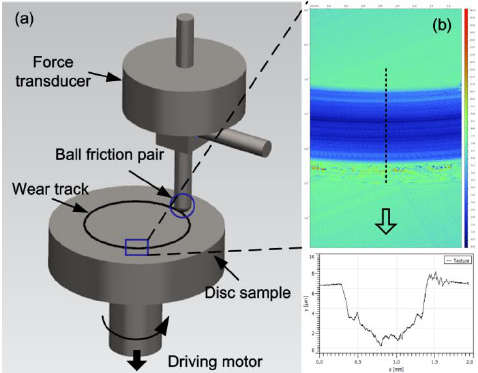
Figure 2. Schematic diagram of wear experimental apparatus ( a ) and schemes of cross-sectional profile measurement of the wear track ( b ).